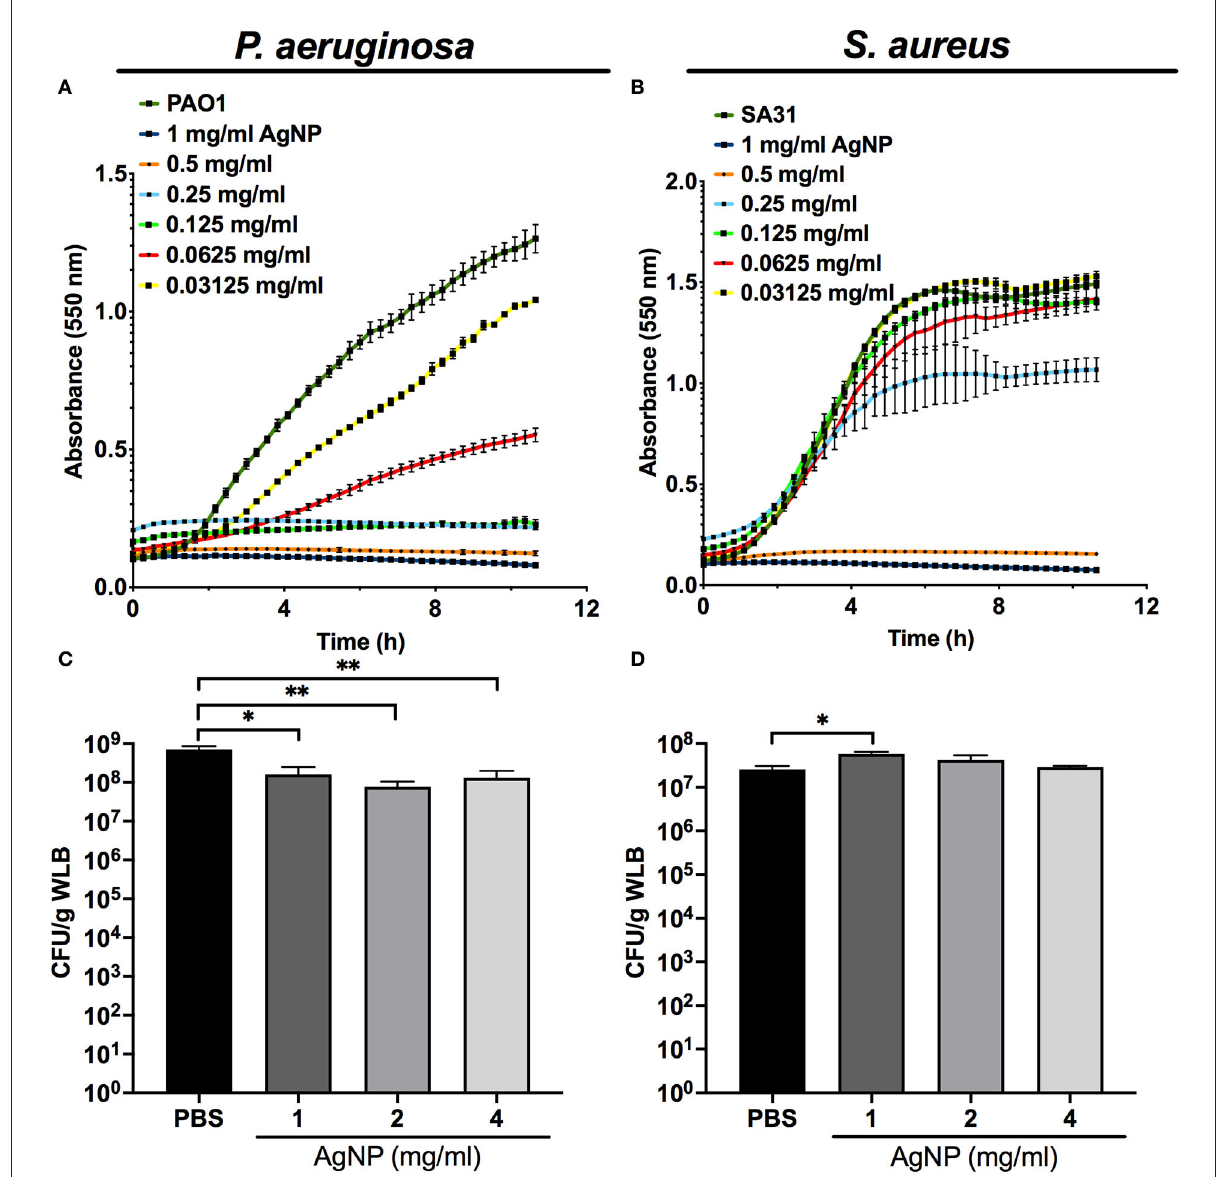
FIGURE3 Antimicrobial capacity of silver nanoparticles (AgNP) on P. aeruginosa and S. aureus . Antimicrobial kinetic assay of silver nanoparticles (AgNP) on P. aeruginosa and S. aureus planktonic cultures (A,B) and dual-species WLB (C,D) . Different AgNP concentrations were used to determine the best antimicrobial concentration. The statistical analysis to determine significance was performed using the Student Unpaired t -test (*0.01 < p < 0.05; ** p < 0.01; vs. non-treated WLB).